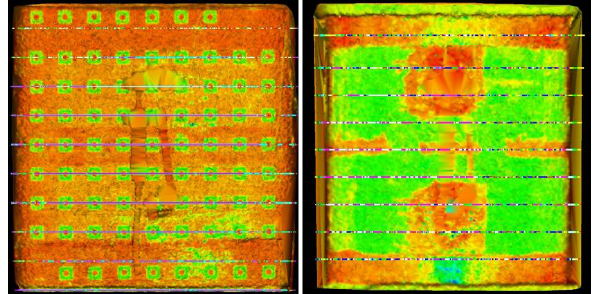
Figure 3. Reference (left) and sample C306P (right)